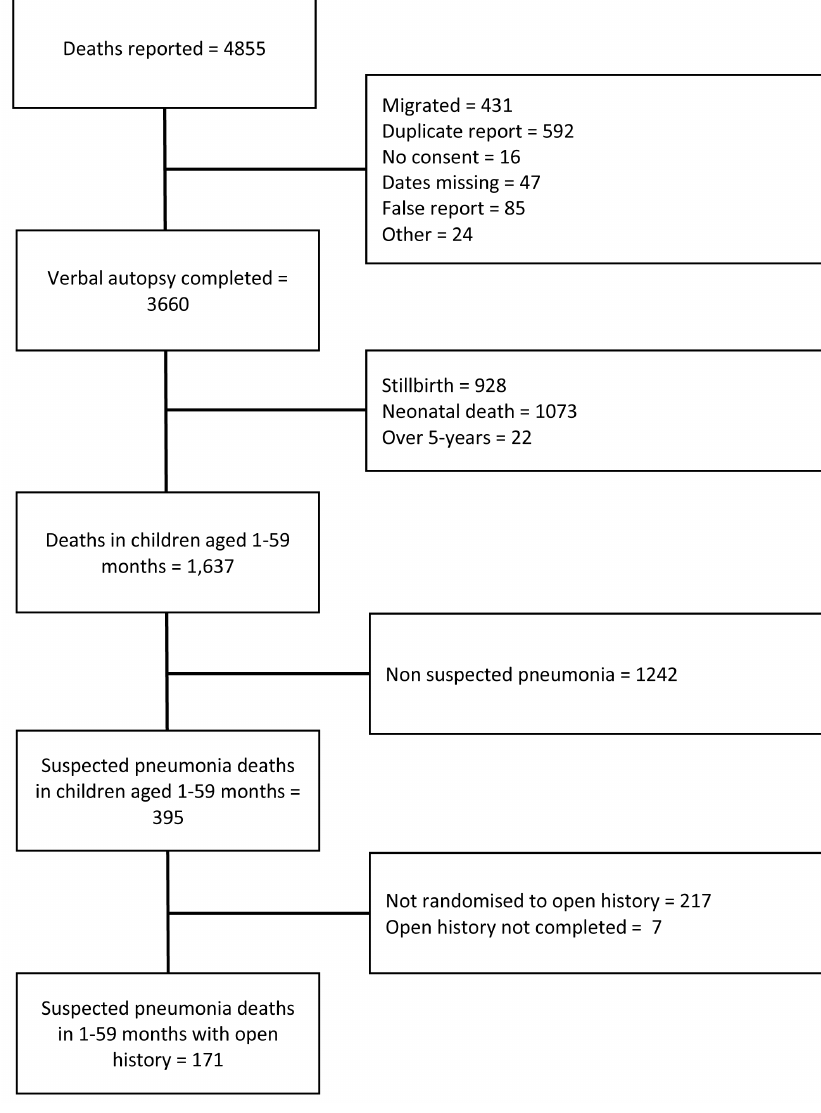
Figure 1. Participant inclusion